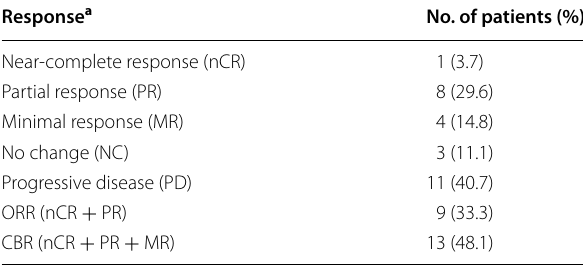
Table 2 Therapeutic responses of 27 RRMM patients